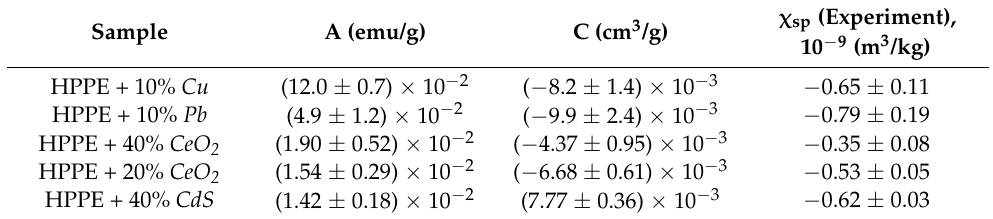
Table 11. Parameters of linear regression and magnetic susceptibility of the samples with M S-0 (cid:54) = 0.